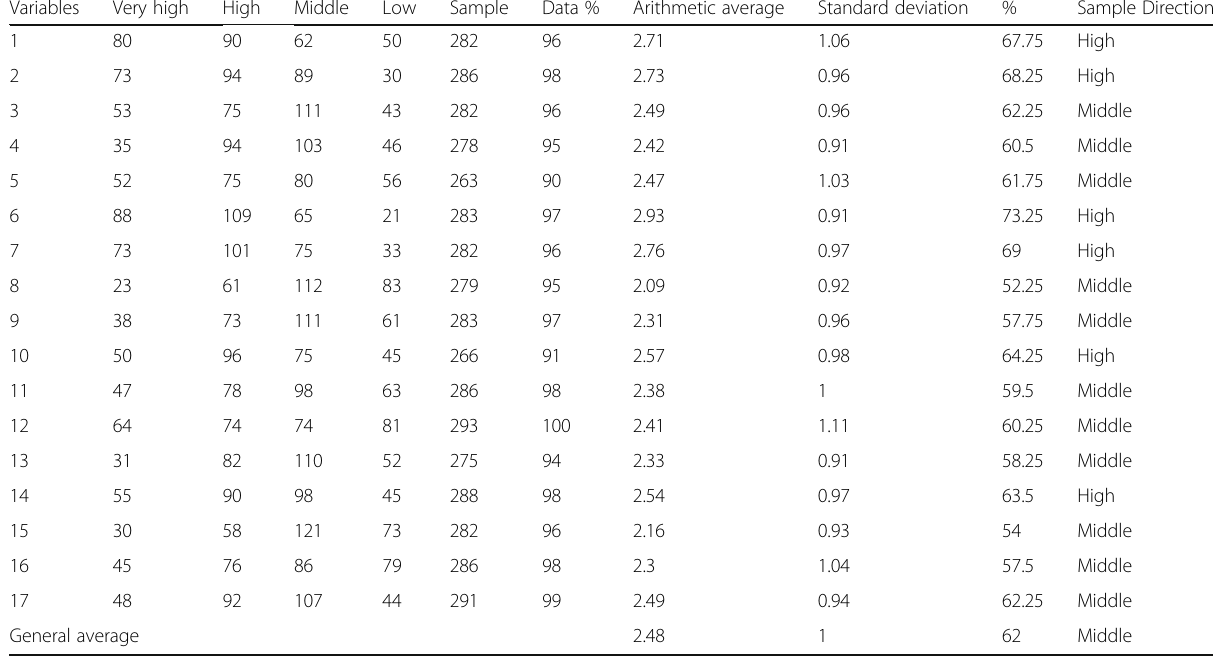
Table 3 Summary of the responses on desertification common variables in Draa Valley Variables